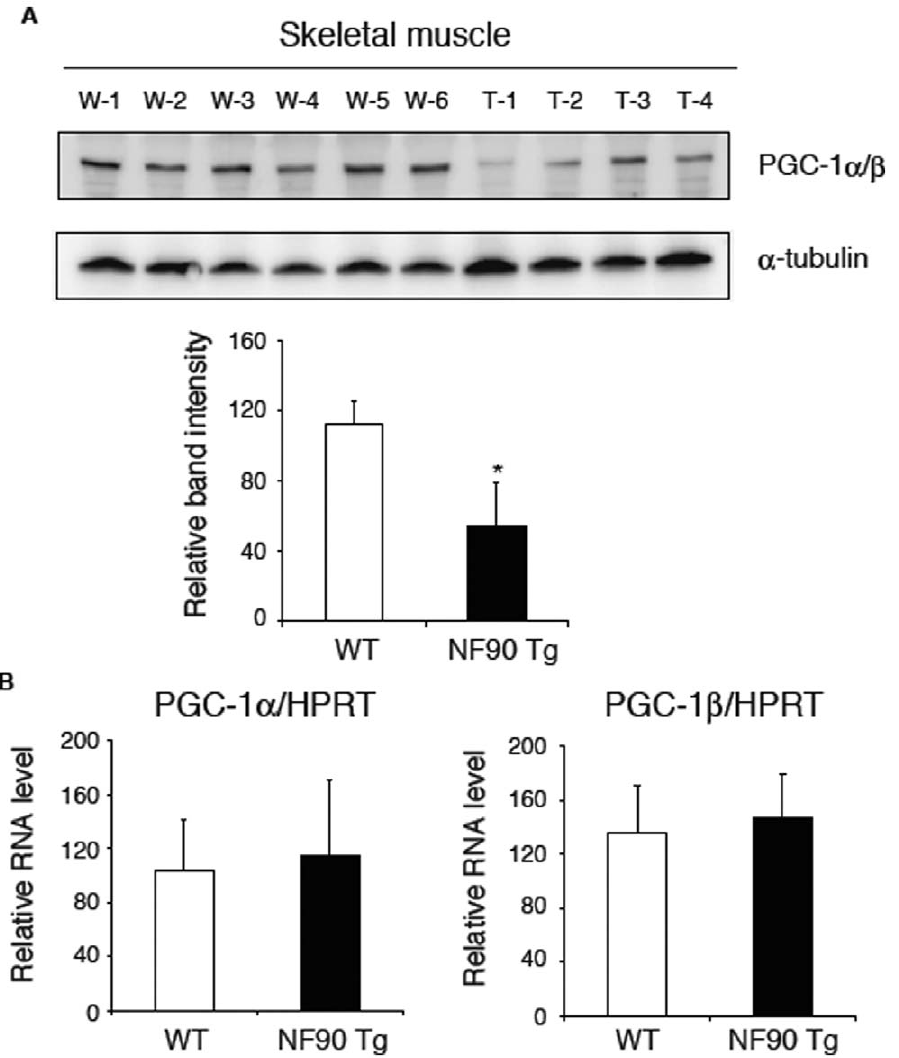
Figure 7. The translation of PGC-1 is depressed in the skeletal muscles of the NF90 Tg mice. (A) Immunoblot analysis of PGC-1 in tissue extractions of skeletal muscles of WT (n=6) and NF90 Tg mice (line TG1) (n=4). Anti- a -tubulin was used as loading control. W-1 to -6, WT; T-1 to -4, NF90 Tg mice (line TG1). Intensities of specific bands in imunoblotting analysis were measured with a densitometer and are presented as a graph. Data are expressed as means 6 SD. *, p , 0.01 relative to WT by a two-tailed Student’s t test. (B) RNAs isolated from skeletal muscles of WT (n=4) and NF90 Tg mice (line TG1) (n=3) were analyzed for expressions of PGC-1 a and PGC-1 b by RT-qPCR. HPRT was used as an internal control and for normalization of the data. Data are expressed as means 6